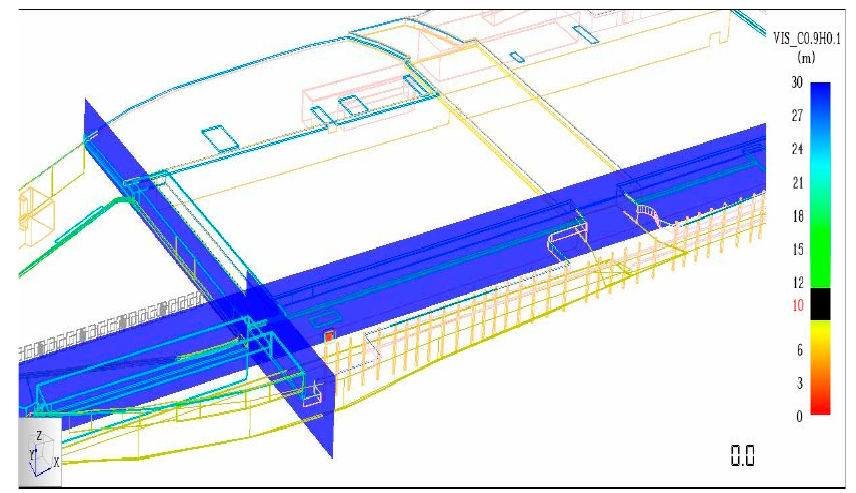
Figure 12. Throat area smoke spread.